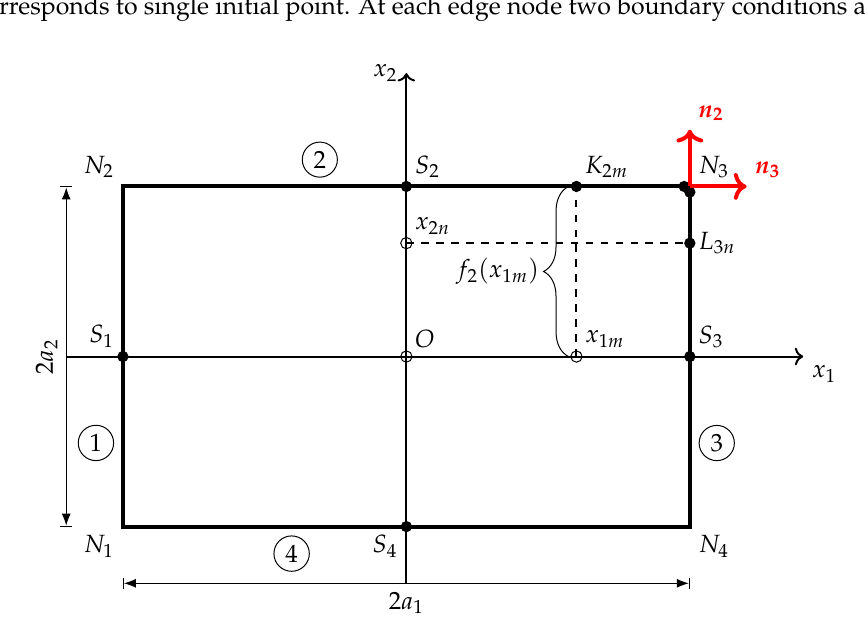
Figure 2. Distribution of current nodes at the contour of rectangular